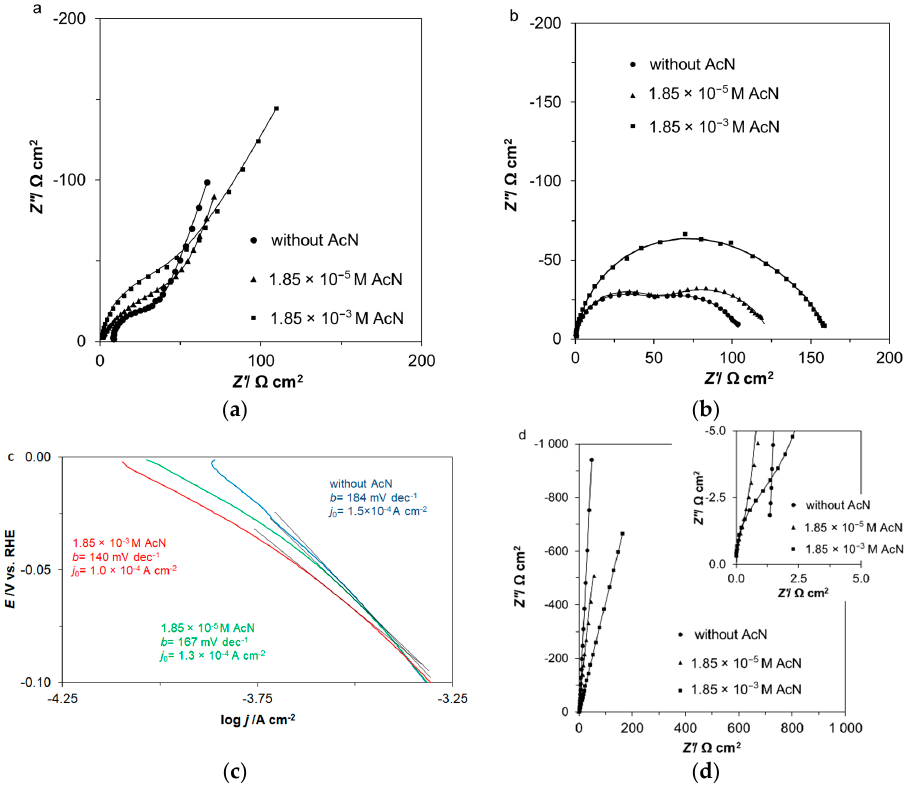
Figure 4. ( a ) Complex-plane impedance plots for the process of UPD of H on Pt polyoriented single-crystal sphere electrode in contact with 0.1 M NaOH and in the presence of AcN for the concentrations indicated, recorded at 293 K for the potential of 100 mV vs. RHE. The solid lines correspond to representation of the data according to the equivalent circuit shown in Figure 3a; ( b ) as above, but for the process of HER, recorded at the potential of − 50 mV vs. RHE. The solid lines correspond to representation of the data according to the equivalent circuit shown in Figure 3b; ( c ) quasi-potentiostatic cathodic polarization curves (recorded at a rate of 0.5 mV · s − 1 ) under analogous conditions as above; ( d ) as in ( a ) above, but recorded over the double-layer charging potential range (500 mV vs. RHE), exhibiting AcN fairly reversible oxidation process. The solid lines correspond to representation of the data according to the equivalent circuit shown in Figure 3c.